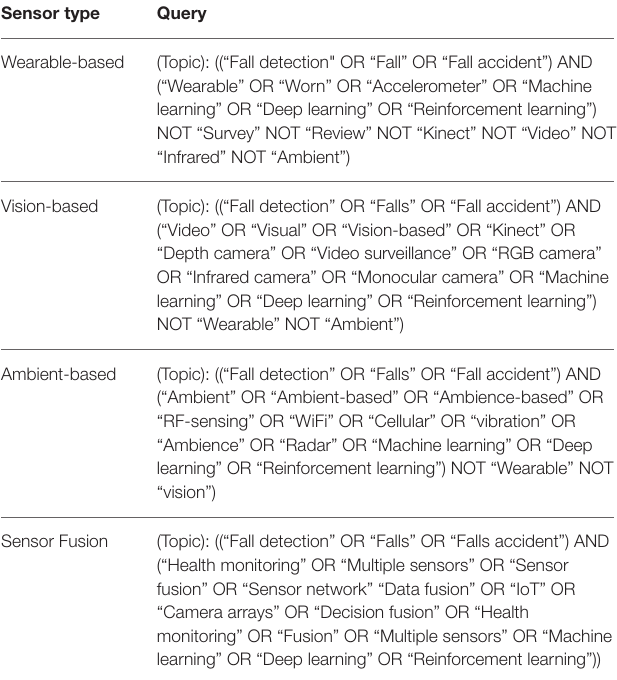
TABLE 2 | Search queries used in Google Scholar and Web of Science for the three types of sensor and sensor fusion. Sensor